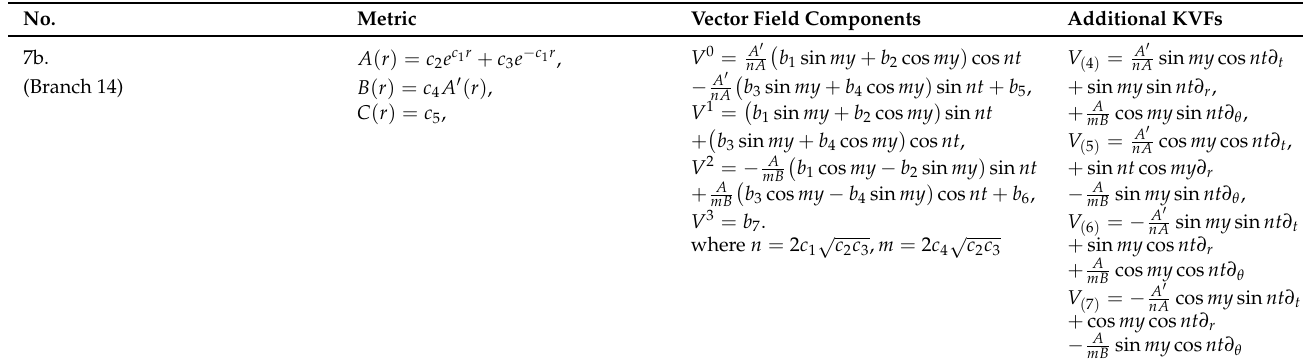
Table 4. Metrics admitting seven